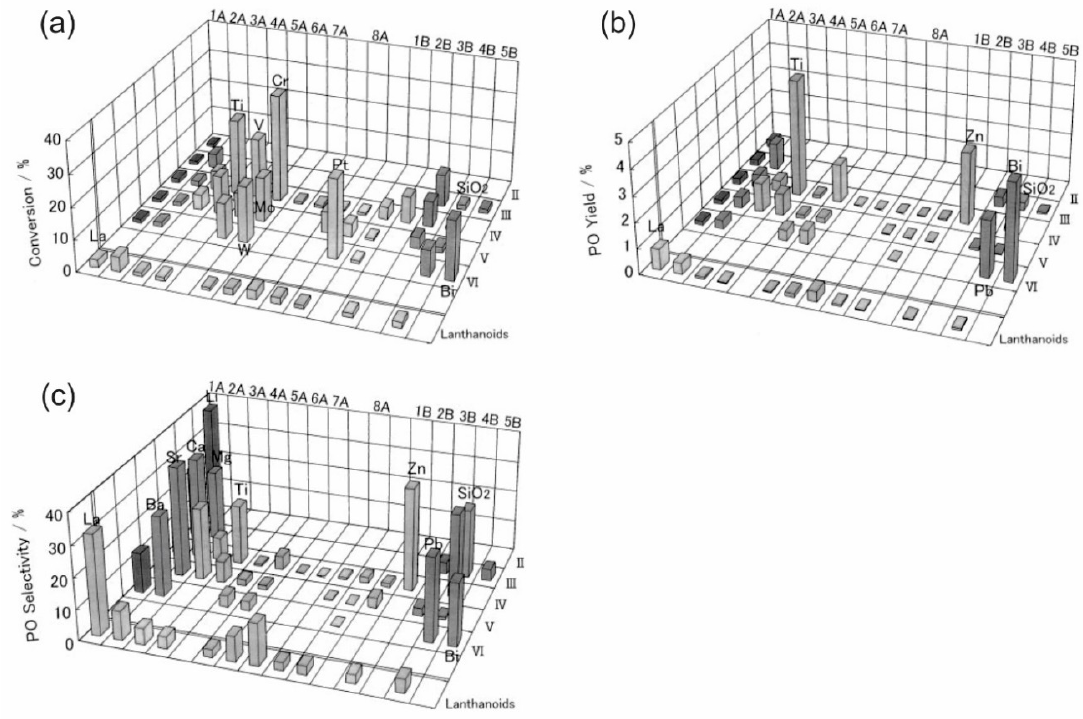
Figure 1. ( a ) Propylene conversion, ( b ) propylene oxide (PO) yield, and ( c ) PO selectivity over various silica-supported catalysts in the photo-epoxidation of propylene through molecular oxygen. The data is collected after 2 h in reaction. Reproduced with permission from is collected after 2 h in reaction. Reproduced with permission from [10] .